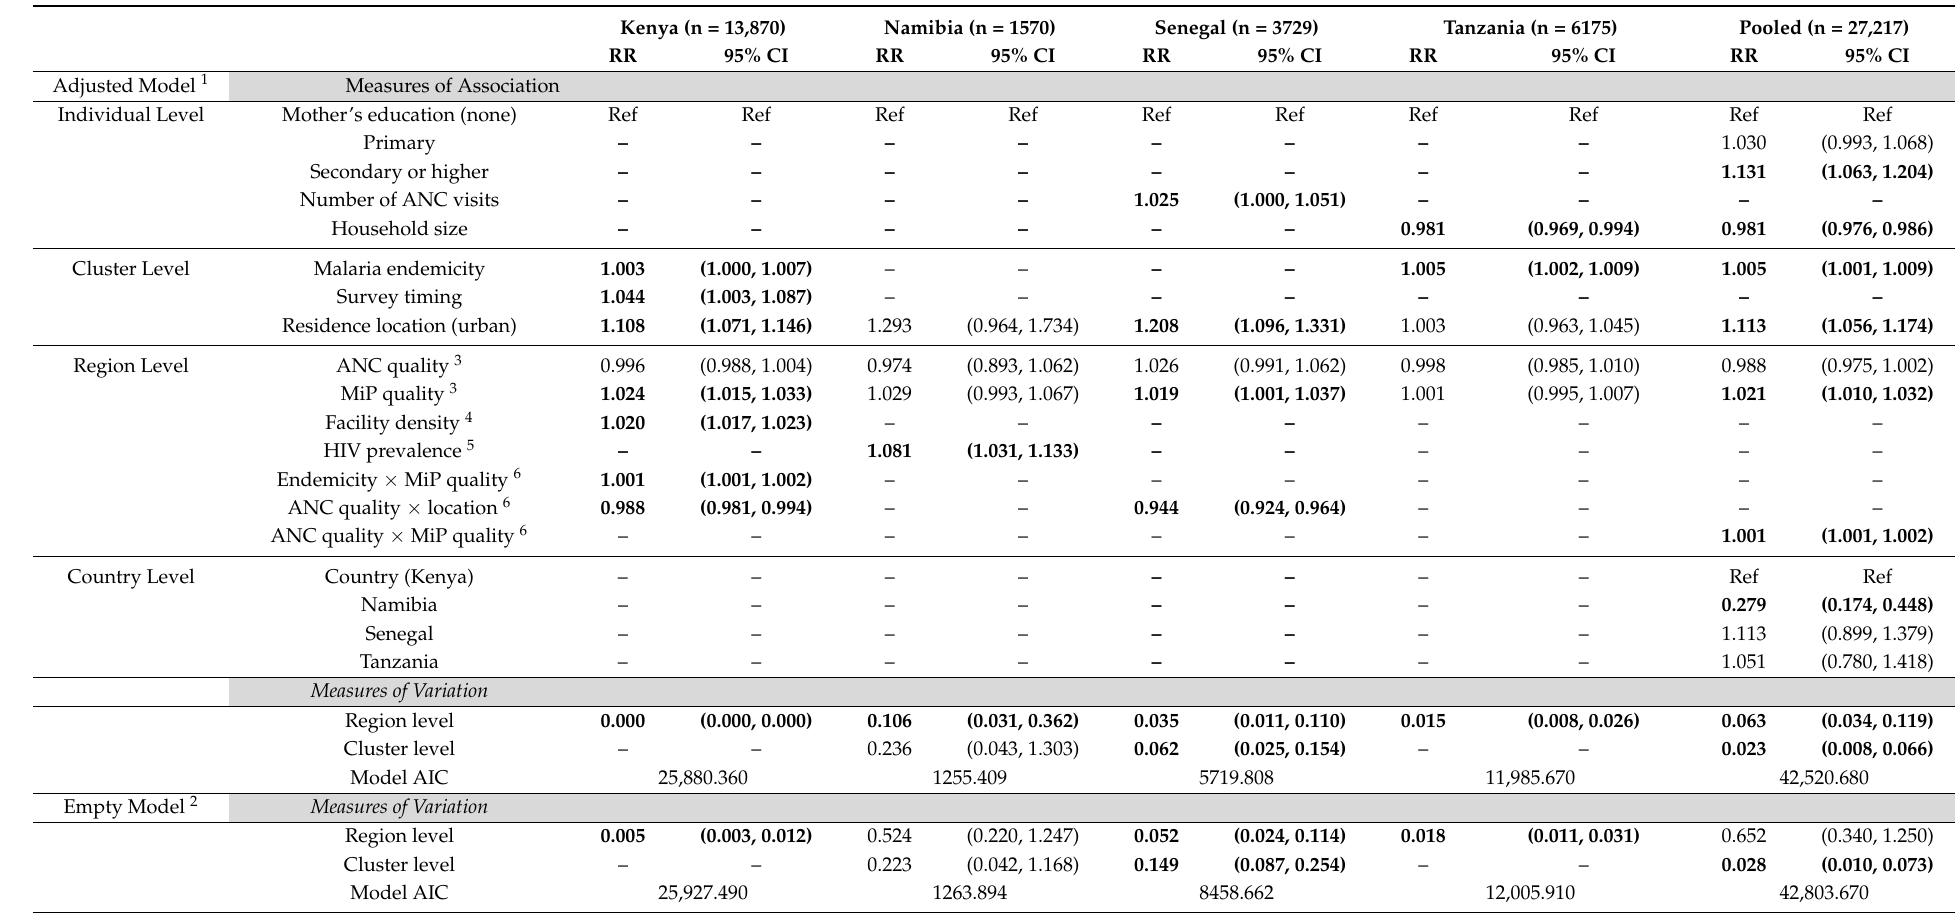
Table 5. Adjusted multilevel mixed effects modified Poisson results for insecticide-treated net use in children under